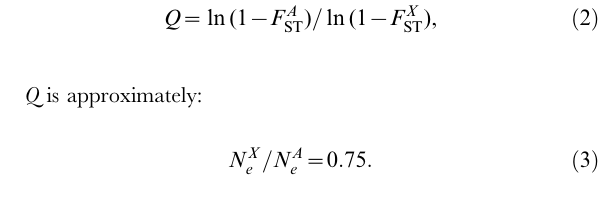
Figure S1 Distribution of genetic variation per HapMap population and phase. SNPs were classified in ten minor allele groups based on their frequency in each population and further subdivided by HapMap phases: 1 (blue), 2 (green), and 3 (red). The number of SNPs genotyped in each phase ( n 1 .. 3 ) and the total number of SNPs ( n tot ) are